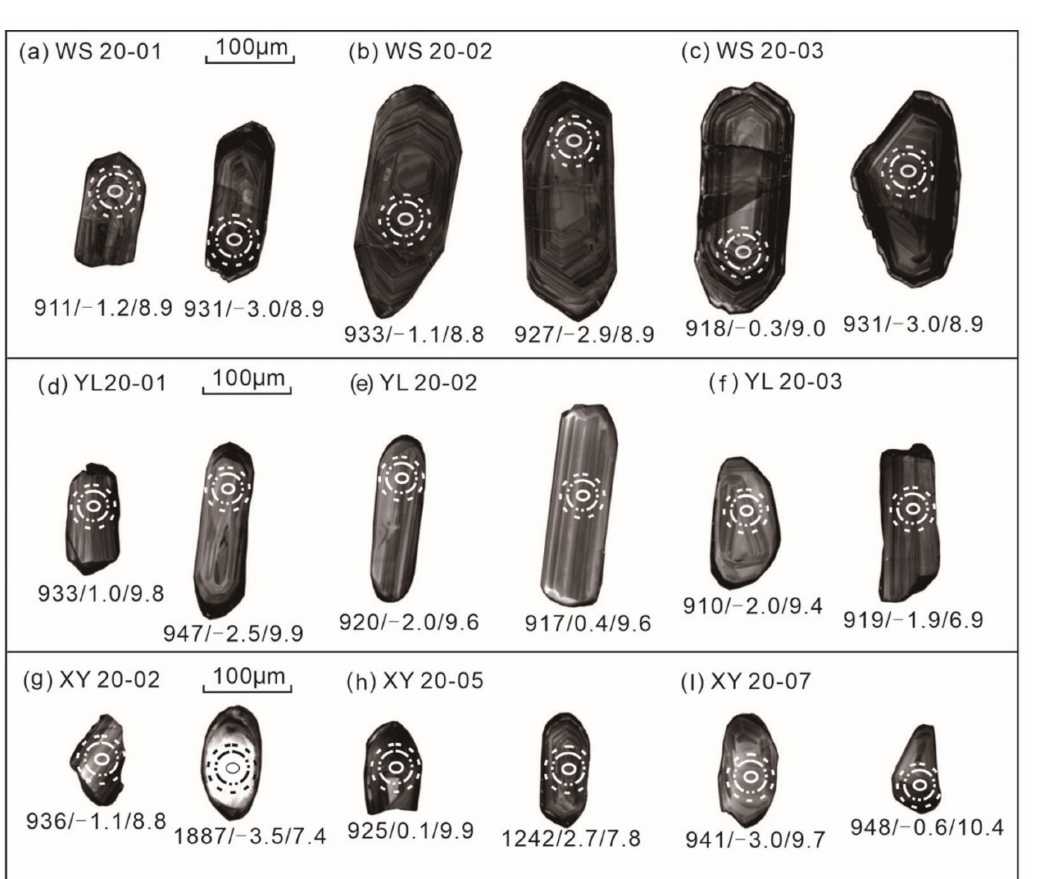
Figure 6. Representative zircon CL images with ages/ ε Hf (t)/ δ 18 O values for the granitic mylonites from Wushan ( a – c ) and granitic gneisses from Yuanlong ( d – f ) and Xinyang ( g – i ) in the western margin of the NQT. The smaller circles 10 µ m in diameter, the medium circles 30 µ m in diameter, and the dashed circles 40 µ m in diameter represent analytical sites for the O, U–Pb, and Lu–Hf isotope determinations,